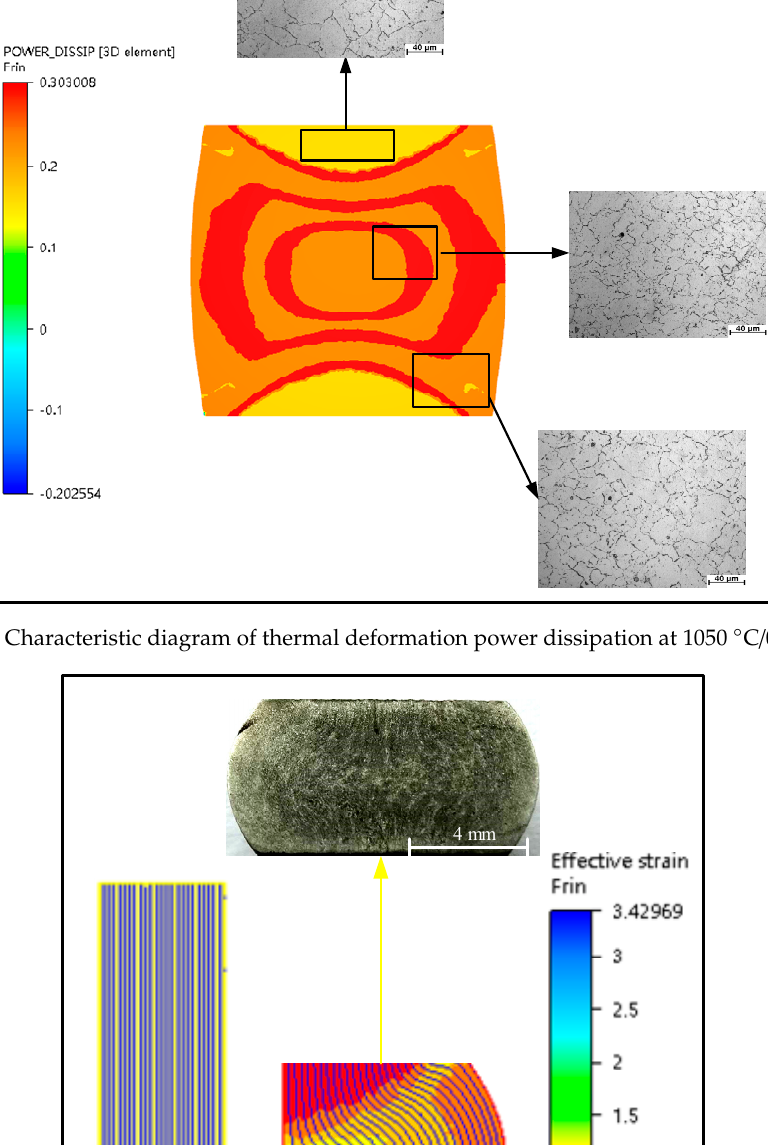
Figure 21. Distribution of flow line on various state: ( a ) start of the process; ( b ) 1100 °C/0.7/0.05 s − 1 .